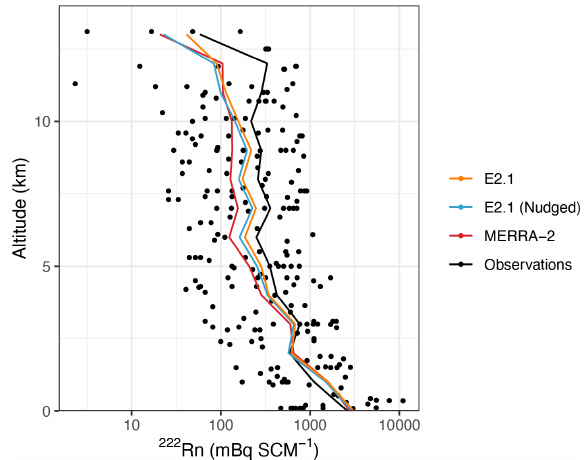
Figure 10. Mean observed vertical profile of 222 Rn compared to the model sampled at month and location of observations. The units are mBq per standard cubic meter at 0 ◦ C and 1atm, equivalent to a linear transformation of the molar mixing ratio (5.637mBqSCM − 1 = 1.0 × 10 − 22 mol 222 Rn(mol air) − 1